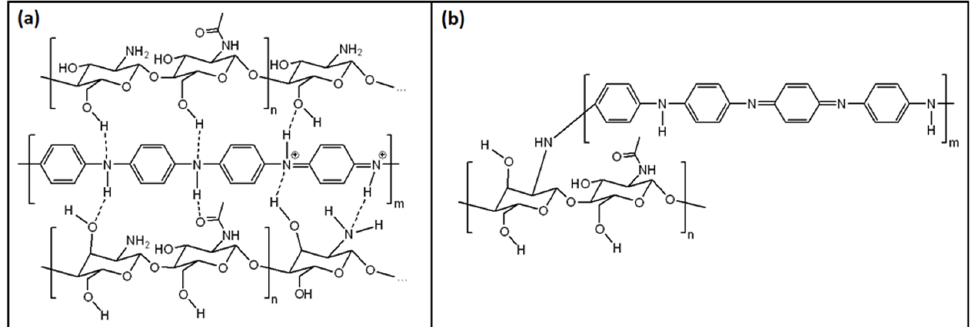
Figure 6. Schematic structures of chemical bonding between PANI and CHT units: ( a ) hydrogen bonding (PANI/CHT); ( b ) covalent bonding via grafting (PANI-g-CHT; “chitaline”). Adapted with permission from the results presented in [77,90–97].